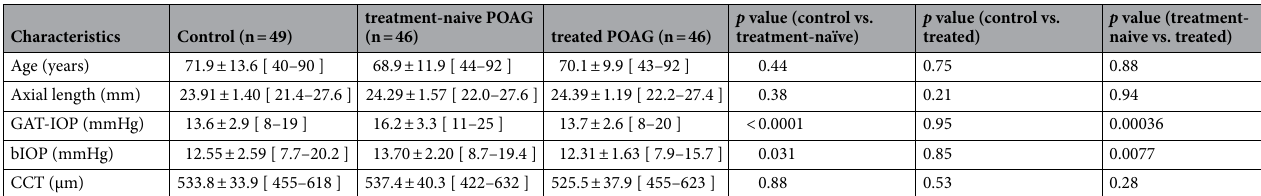
Table 2. Basic characteristics of subjects. GAT-IOP Goldmann applanation tonometry measured intraocular pressure, bIOP biomechanical IOP, CCT central corneal thickness.